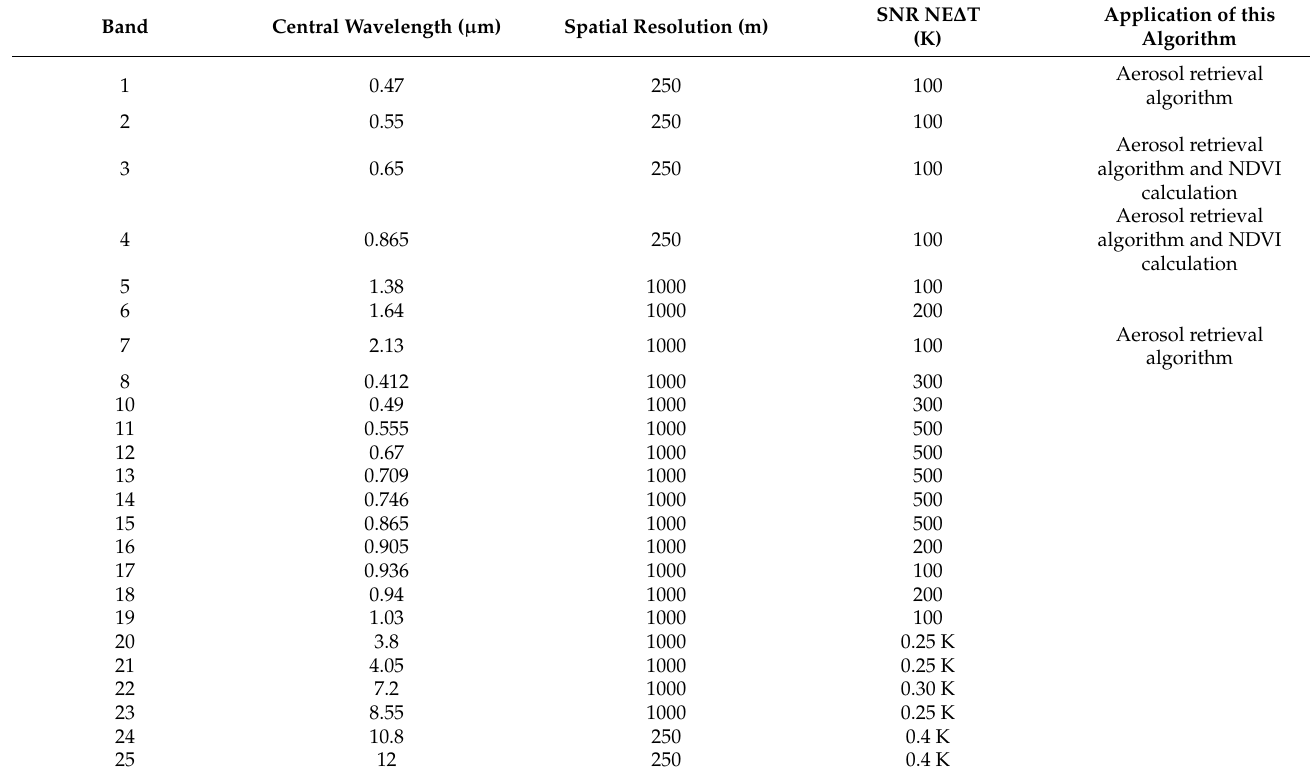
Table 1. The characteristics of MERSI-II